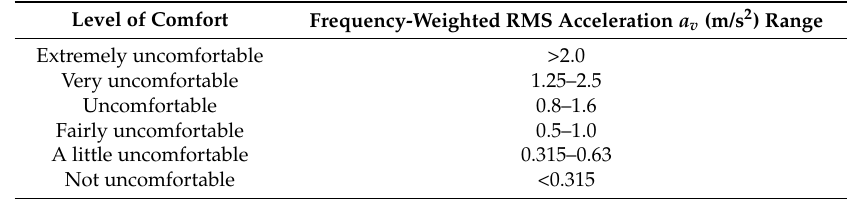
Table 2. Vibration magnitude comfort levels (ISO